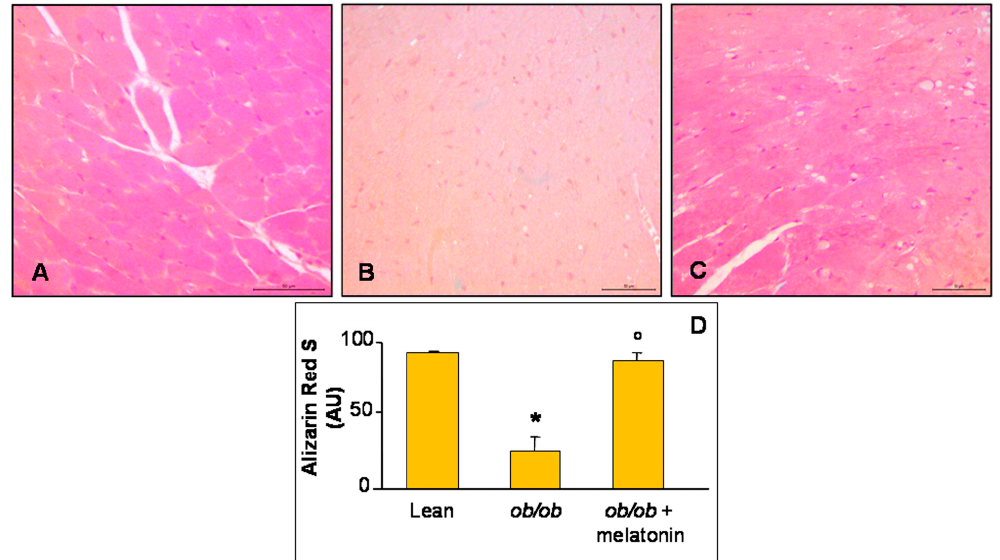
Figure 2. Alizarin Red S staining evaluation. Photomicrographs showing Ca 2+ accumulation in ventricular cardiomyocytes of lean mice treated and not treated with melatonin ( A ), ob / ob mice ( B ) and ob / ob mice treated with melatonin ( C ). Lean mice treated or not with melatonin displayed similar “normal” cardiomyocytes Ca 2+ accumulation data, so they are defined generically as “lean” mice. Note a bright orange to red Ca 2+ salts presence in lean mice, whereas a decreased accumulation in ob / ob mice and a significant recovery after melatonin treatment. Alizarin Red S staining. Scale Bar = 50 µm. The graph ( D ) summarize the quantitative analysis of Alizarin Red staining. * p ≤ 0.05 significant vs. lean mice; ° p ≤ 0.05 significant vs. ob / ob mice.